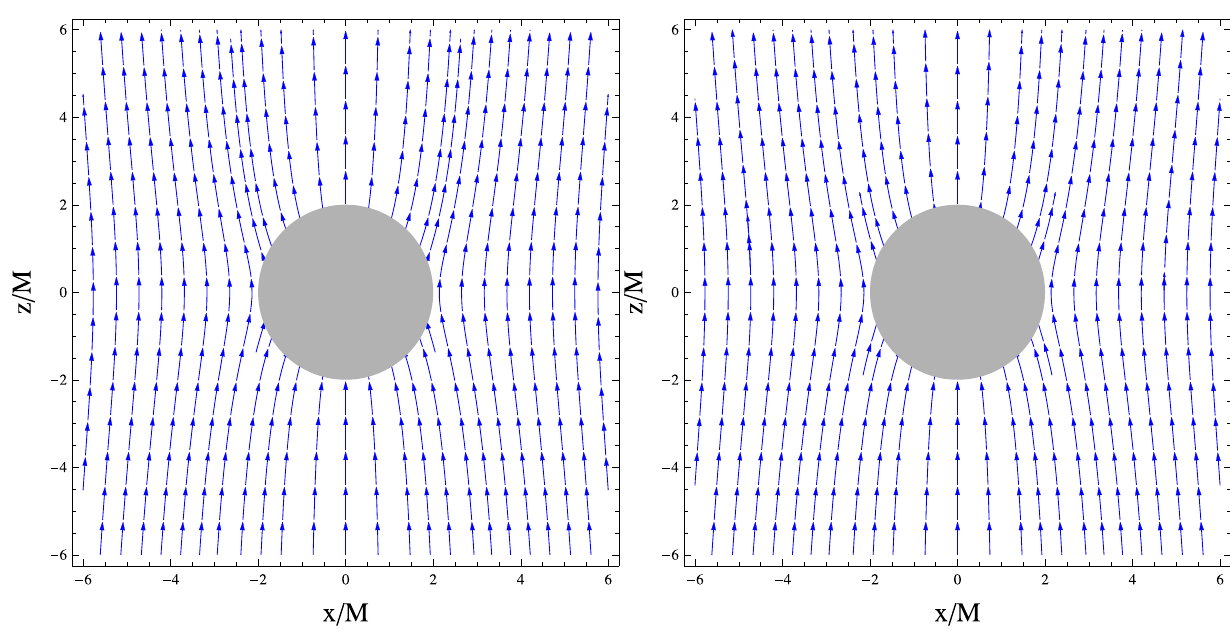
Fig. 1 Plot showing the configuration of magnetic field lines in the vicinity of a magnetized Ernst black hole. The grey-shaded area shows the black hole horizon. Note that left/right panels respectively refer to B = 0 . 1 / 0 . 5. (Note here that we consider B → BM as a dimensionless quantity, having set G = c =